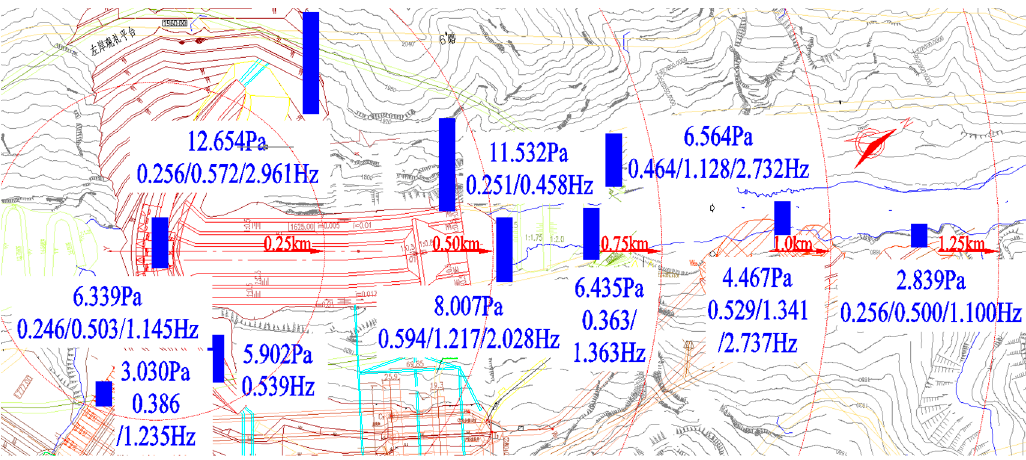
Figure 5. Numerical turbulent flow model of Jinping.